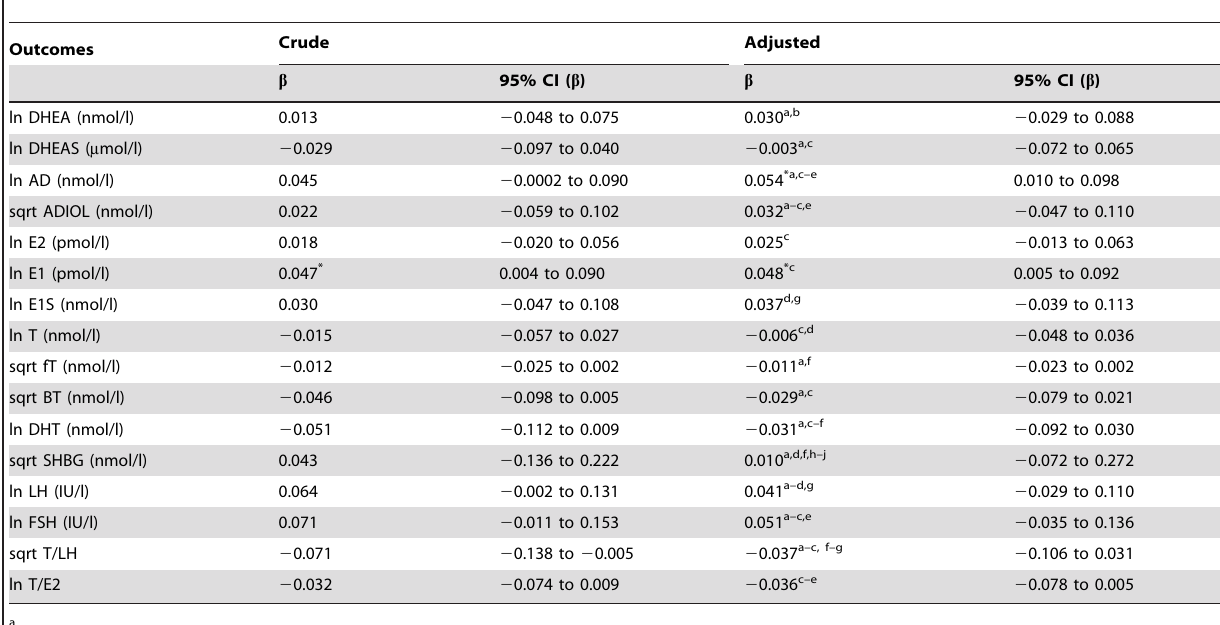
Table 4. Regression coefficients ( b ) for association between serum PCB-153 levels and the outcome variables.